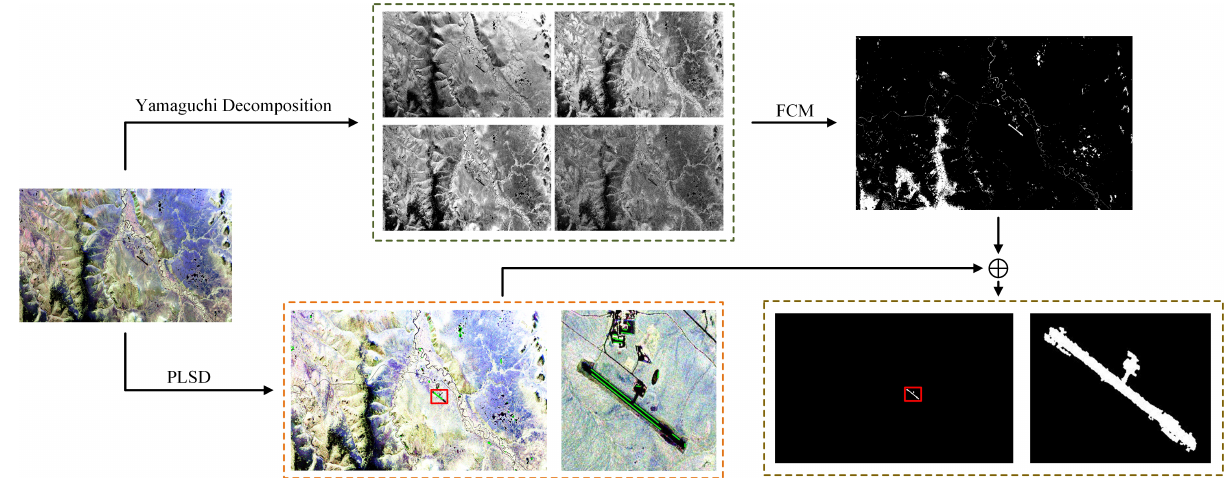
Figure 7. Flowchart of the airport detection method. ⊕ means take the intersection. Red rectangles mark the airport